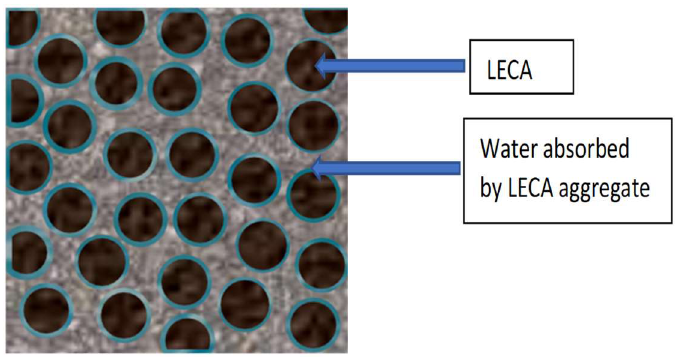
Figure 5. Internal curing of concrete.